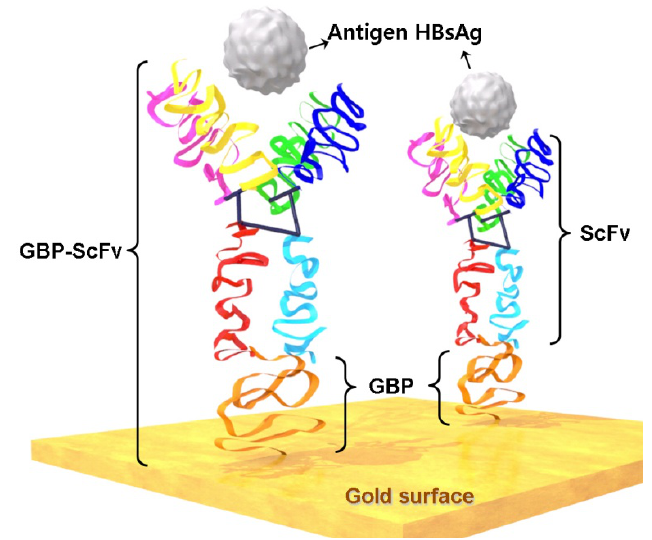
Figure 1. Schematic diagram of bio-recognition onto the gold surface by GBP-fusion proteins and detection of targets (Immobilization of single-chain variable fragment antibody via 6HGBP-ScFv fusion protein for the detection of